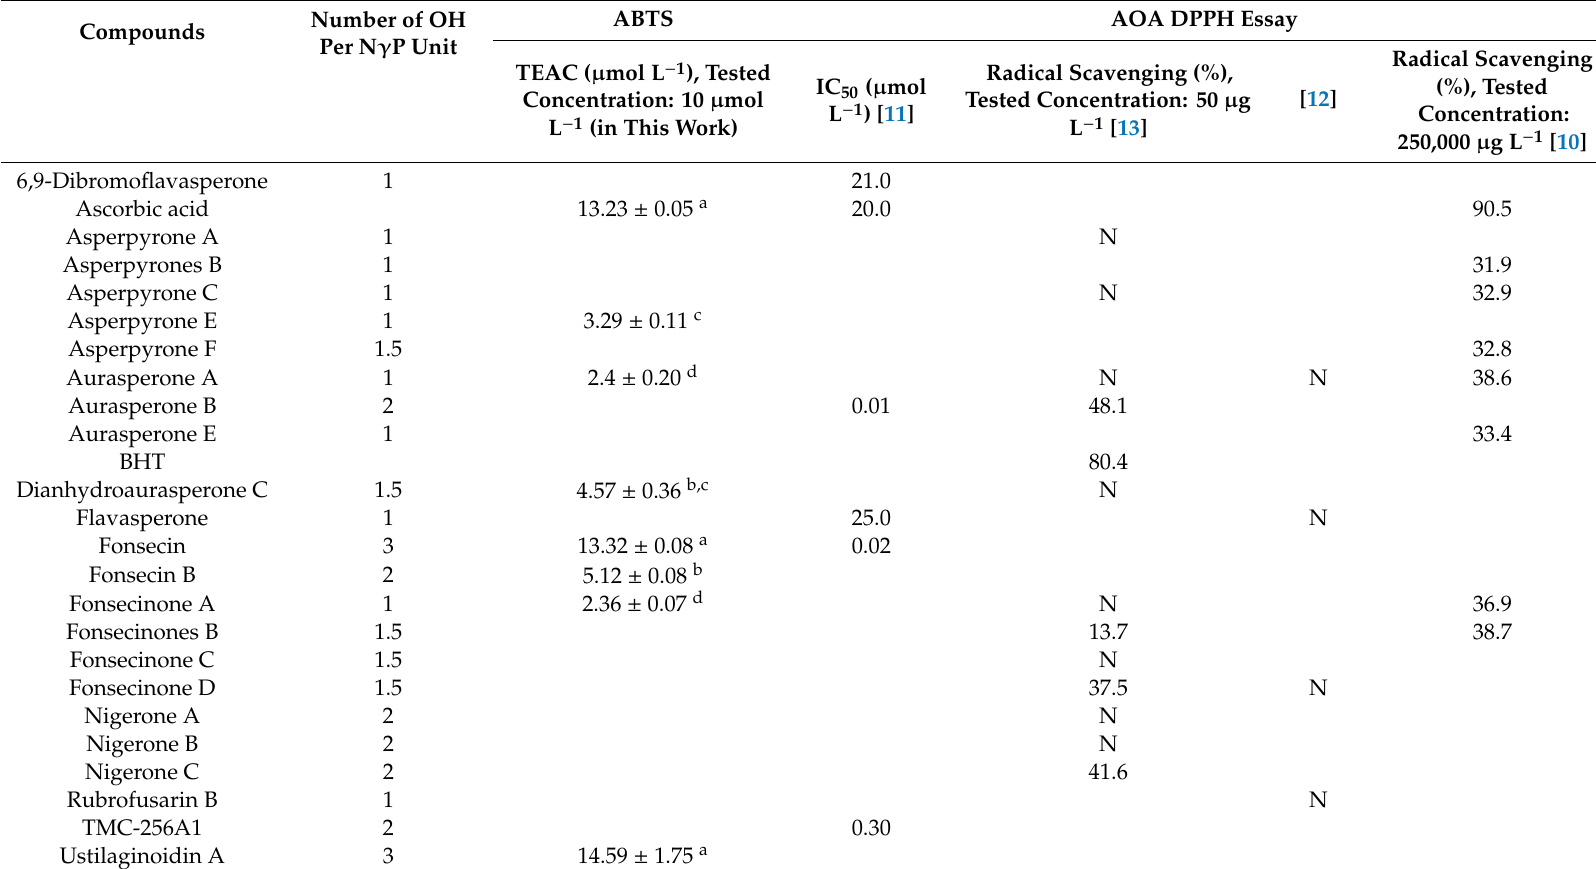
Table 1. Antioxidant activity (AOA) of the N γ Ps reported in the